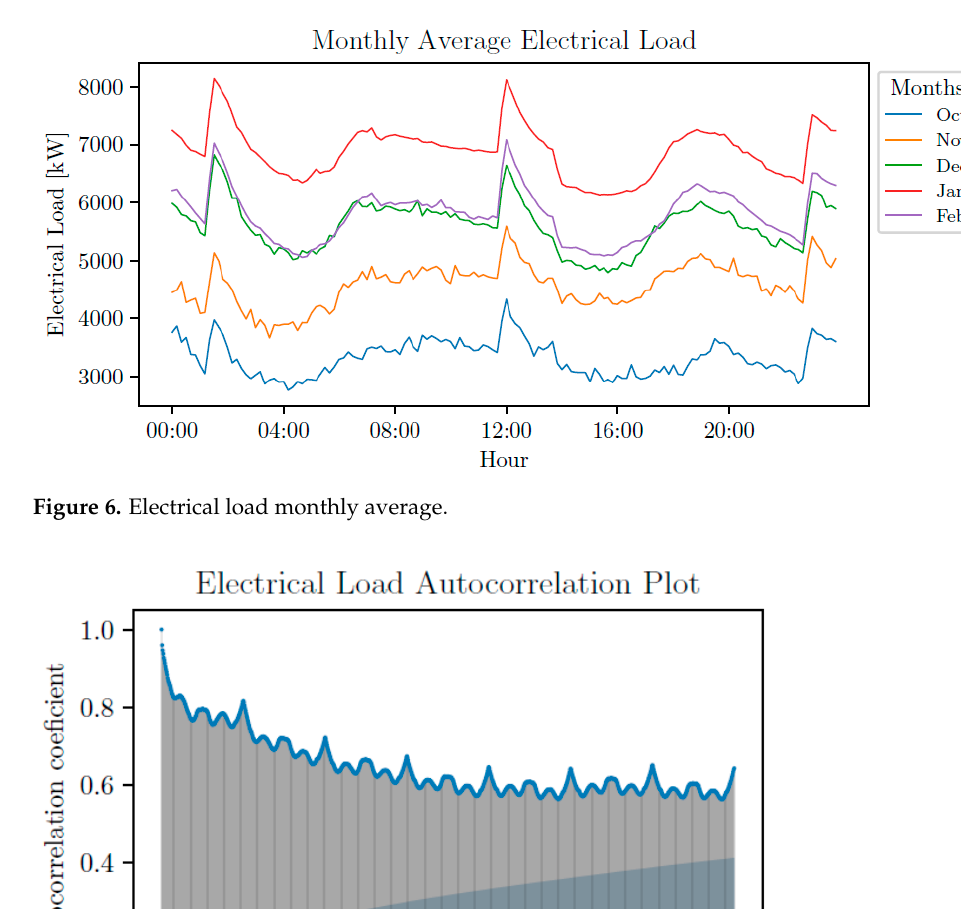
Figure 5. Electrical load: daily average.